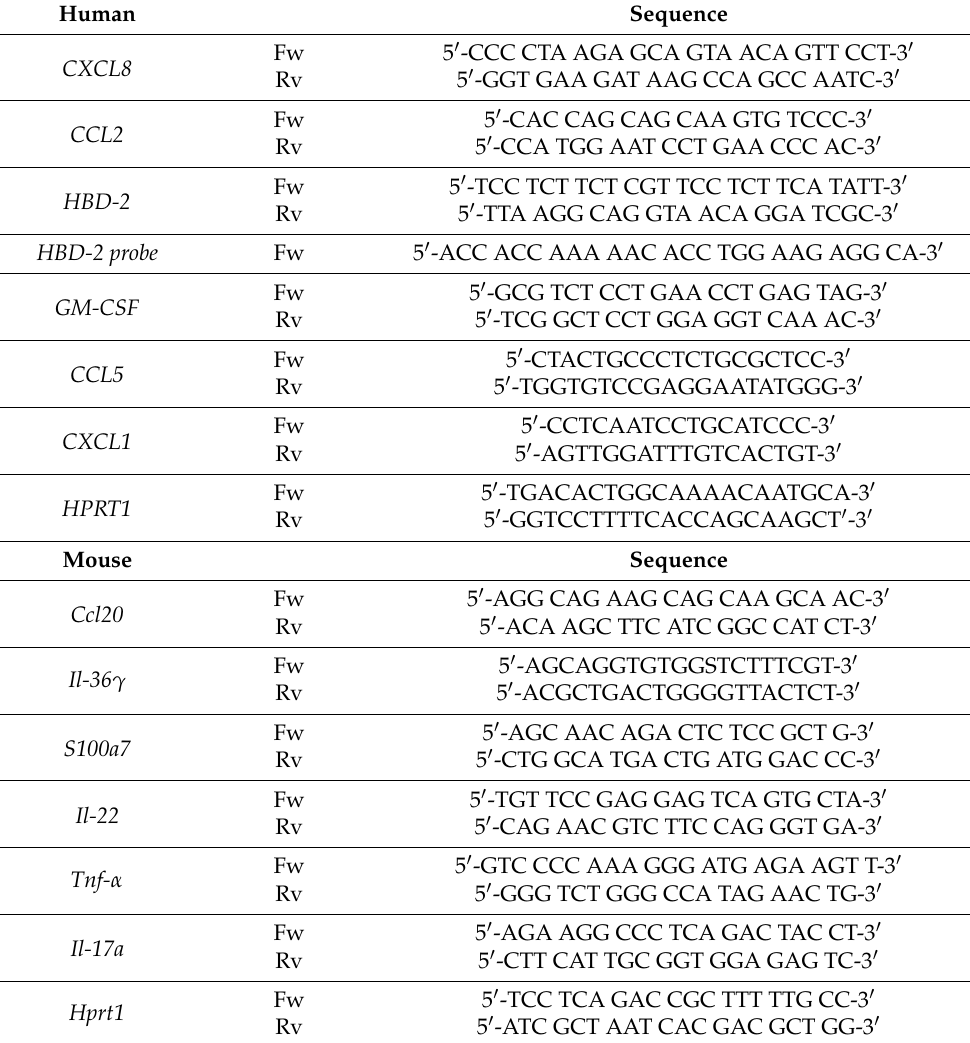
Table 1. List of primer sequences used for real-time PCR analysis on human and mouse samples.